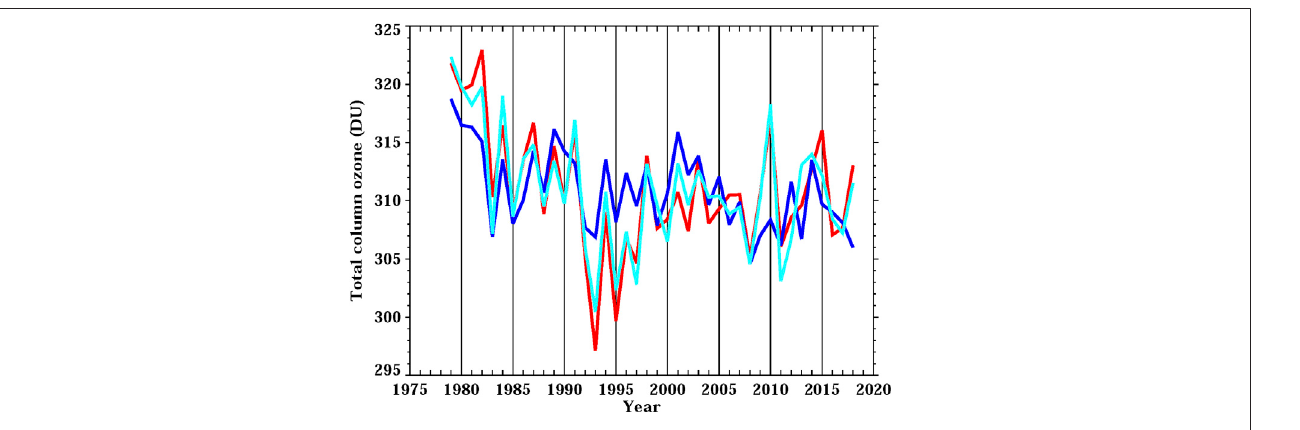
FIGURE 6 | Evolution of the northern hemisphere mean TCO obtained from the MSR2 data (red line) and retrieved from proxies without (blue line) and with Arosa/ Davos TCO as an additional proxy (light blue line). The correlation coef fi cients are 0.64 and 0.94 for the cases without and with Arosa/Davos TCO.